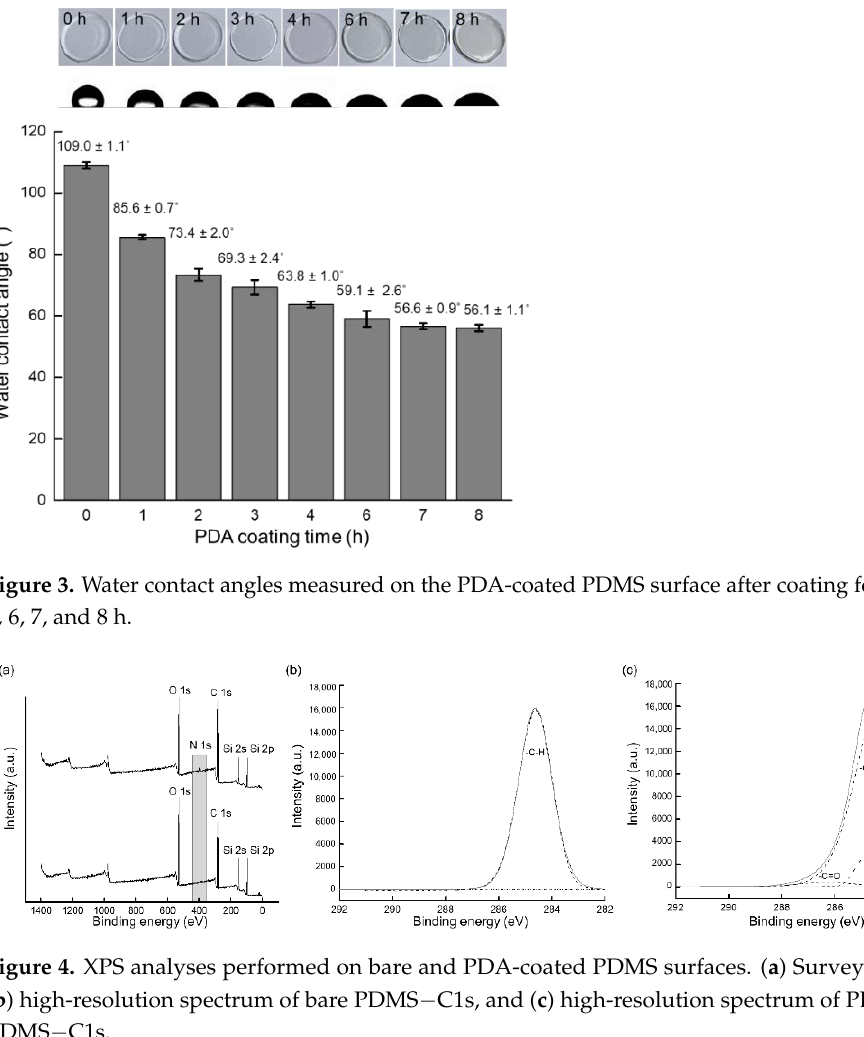
Figure 3. Water contact angles measured on the PDA-coated PDMS surface after coating for 0, 1, 2, 3, 4, 6, 7, and 8 h.